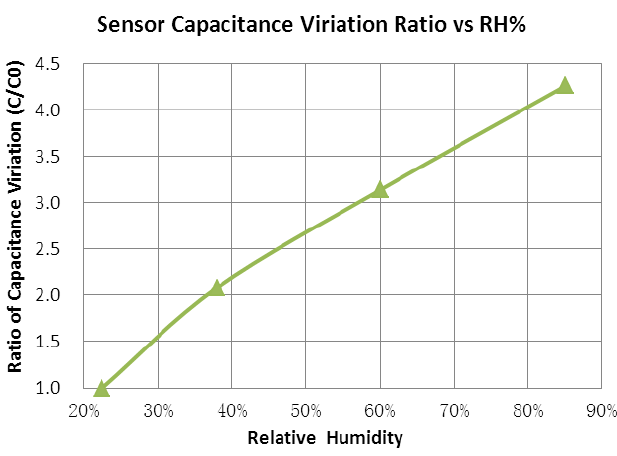
Figure 10. Sensor capacitance variation ratio of C/CO with different Figure 10. S ensor capacitance variation ratio of C/CO with different RH. Figure 10. S ensor capacitance variation ratio of C/CO with different RH.